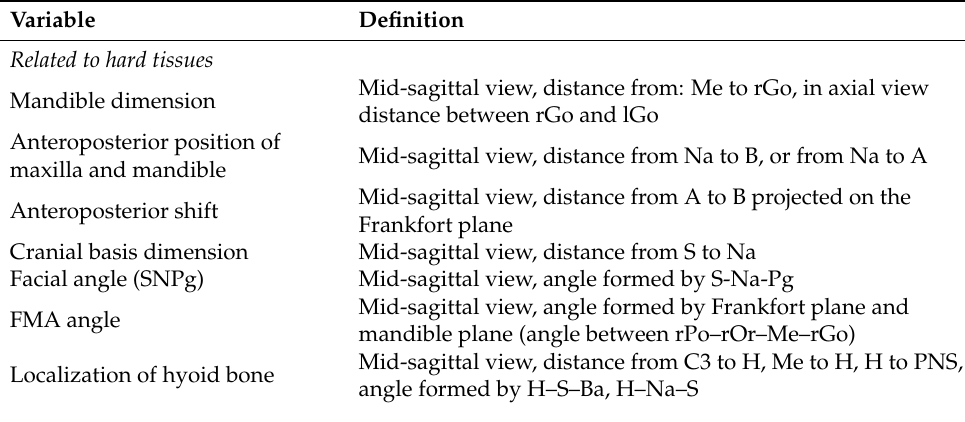
Table 3. Measurements computed from